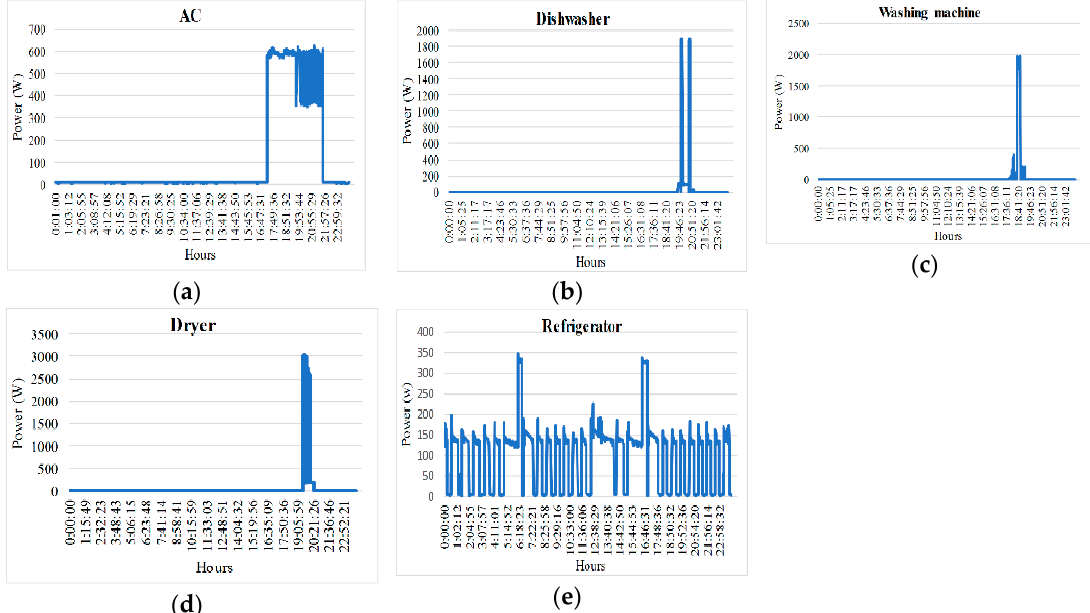
Figure 13. ( a ) Typical daily load profile, ( b ) Room temperature of a typical summer day.